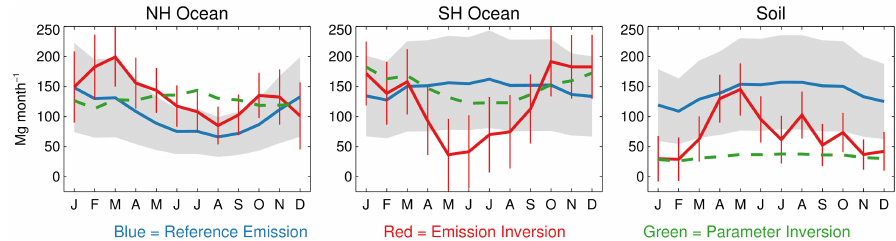
Figure 5. Monthly emissions for the three seasonal sources (NH ocean, SH ocean, and soil) from the reference simulation (blue solid lines), emission inversion (red solid lines), and parameter inversion (green dashed lines). The gray shaded regions and red error bars indicate 1 σ uncertainties for the reference emissions and emission inversion, respectively. Table 3. Comparison of Asian Hg 0 emissions (Mgyr − 1 ) from recent studies.